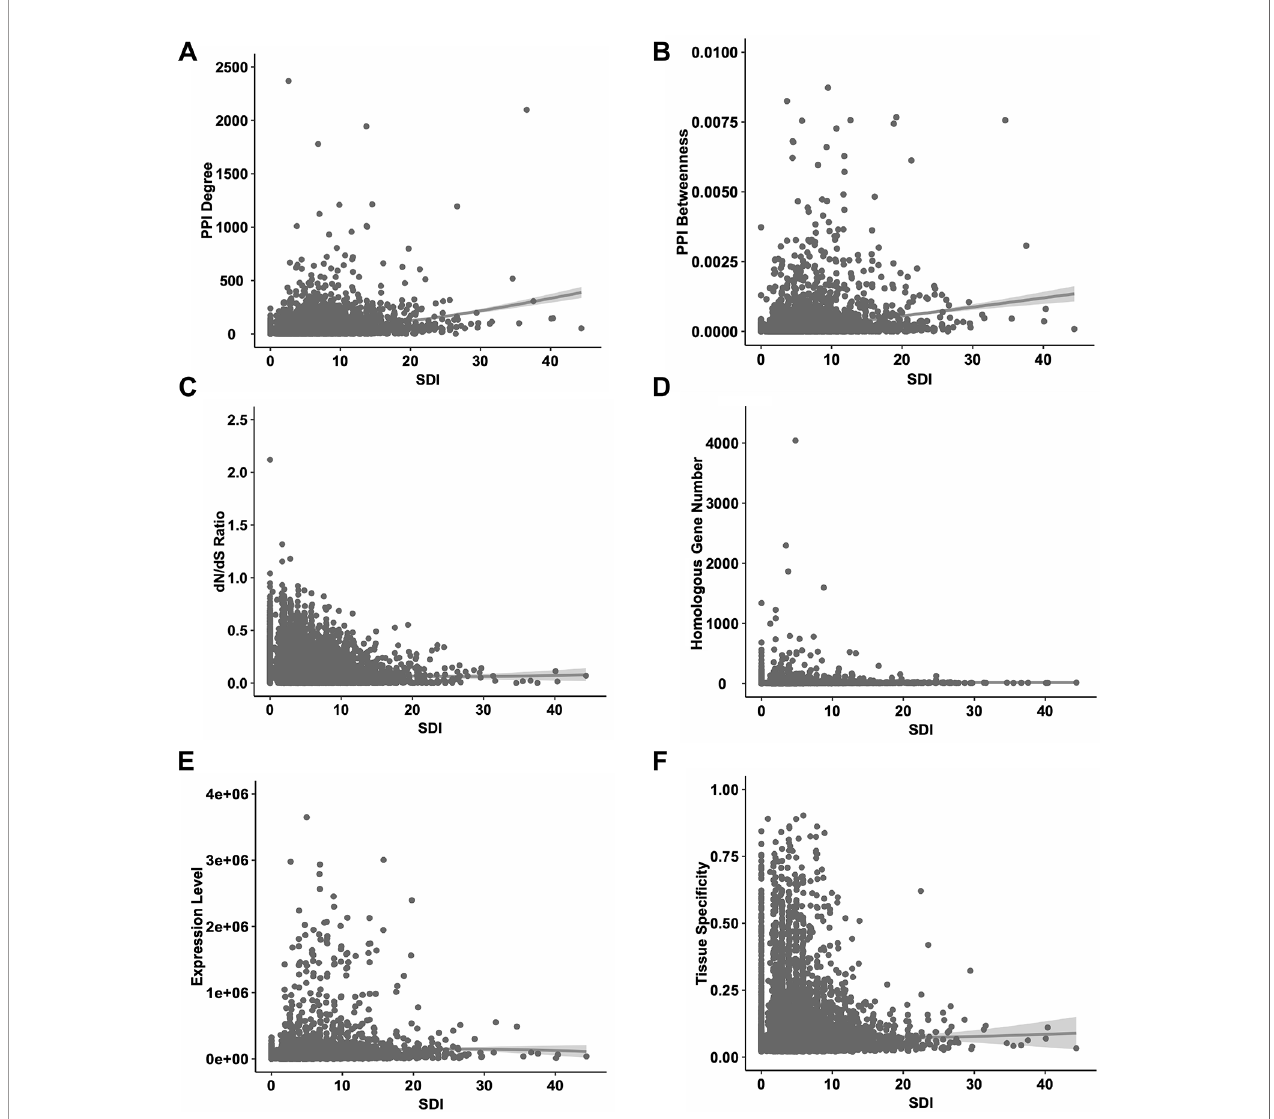
FIGURE 2 | The correlations between SDI and other known measures of essentiality in human genes. The scatter plots show the correlations between SDI and other measures. Genes with higher SDI tend to have higher PPI degrees (A) ; higher PPI betweenness (B) ; lower evolutionary rate measured by dN/dS ratio (C) ; higher homologous gene number (D) ; higher expression level (E) and higher tissue speci fi city (F) . SDI, Subcellular Diversity Index; PPI, protein – protein